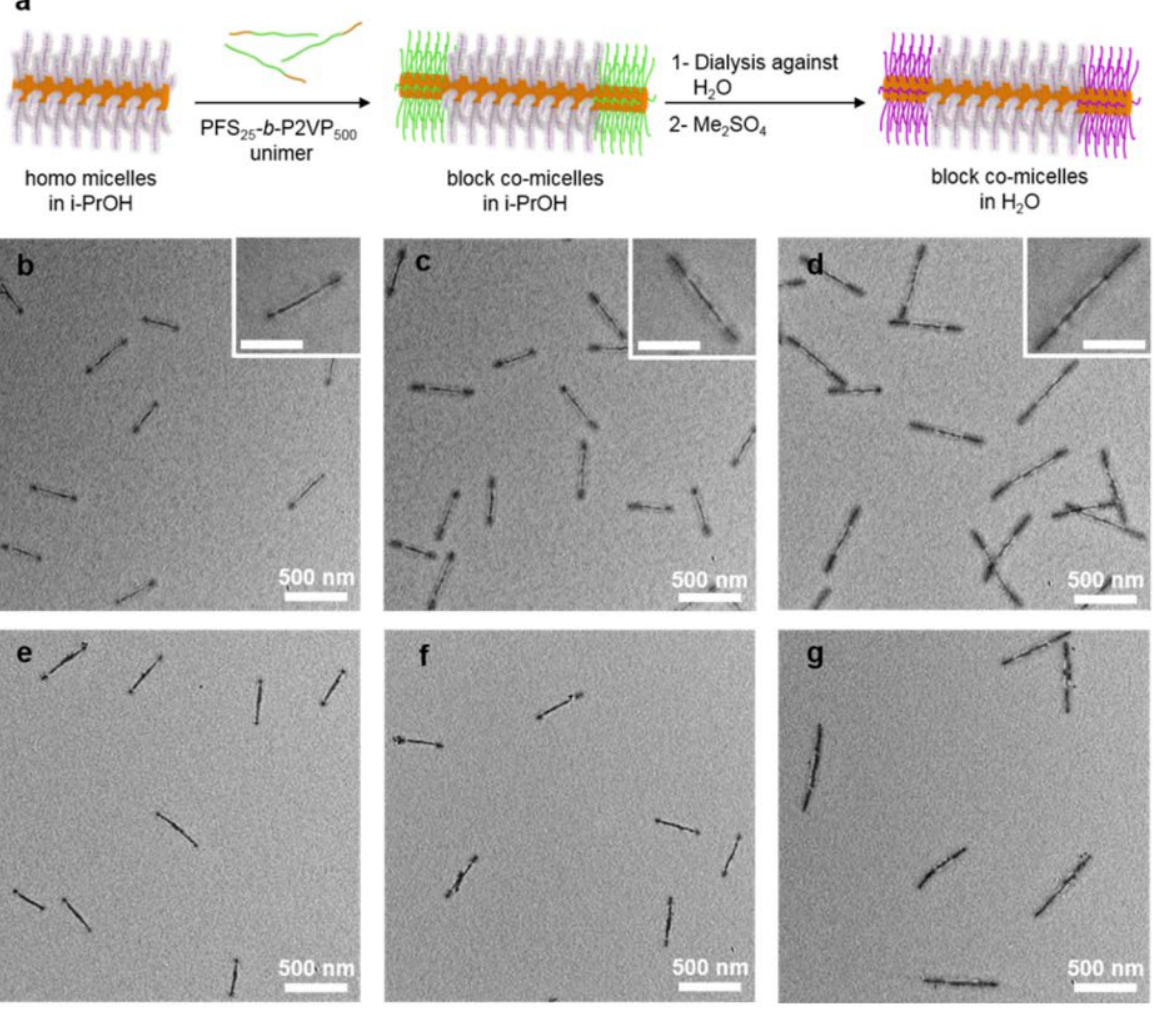
Figure 7. ( a ) Schematic illustration of the preparation of homo-micelles and block co-micelles in isopropanol and water using (PFS 25 -b-P2VP 500 )-b-(PFS-b-(PEO-g-TEG))-b-(PFS 25 -b-P2VP 500 ). TEM images of a monodispersed cylindrical micelle of addition of ( b ) 10 µ g, ( c ) 20 µ g, ( d ) 40 µ g of PFS 25 - b-P2VP 500 unimer to 20 µ g of PFS-b-(PEO-g-TEG) cylinders in isopropanol. ( e – g ) TEM images of triblock co-micelles (shown in ( b – d ) after adding Me 2 SO 4 and dialysis against water. Reprinted with permission from [95]. Copyright 2016 American Chemical